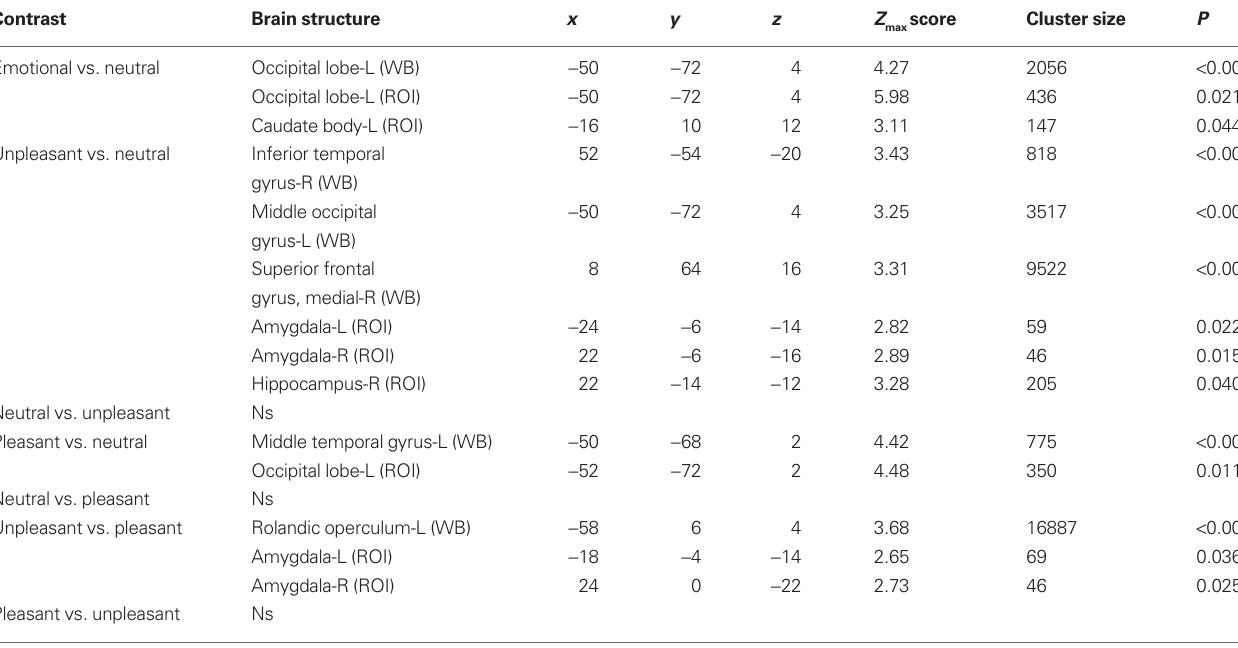
Table 1 | Significant activations revealed by whole brain (WB) and regions of interest (rOi) analysis. Contrast